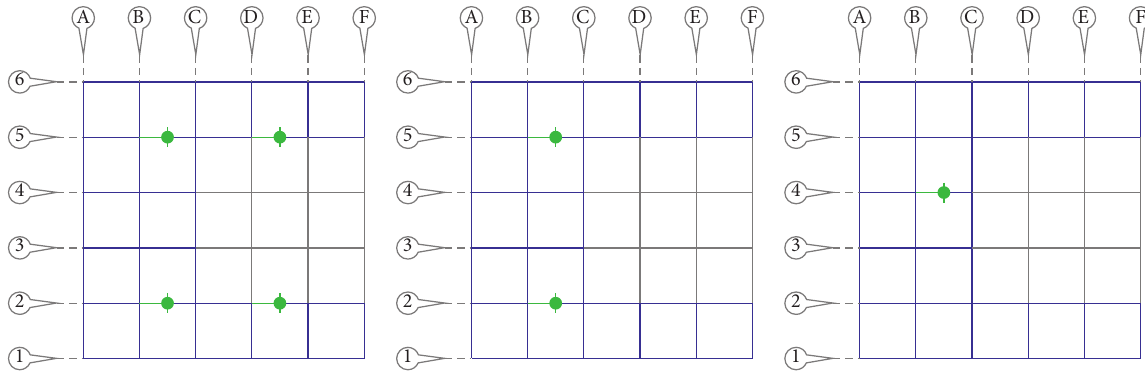
Figure 6: Damper at one point (right), dampers at two points (middle), and dampers at four points (left).